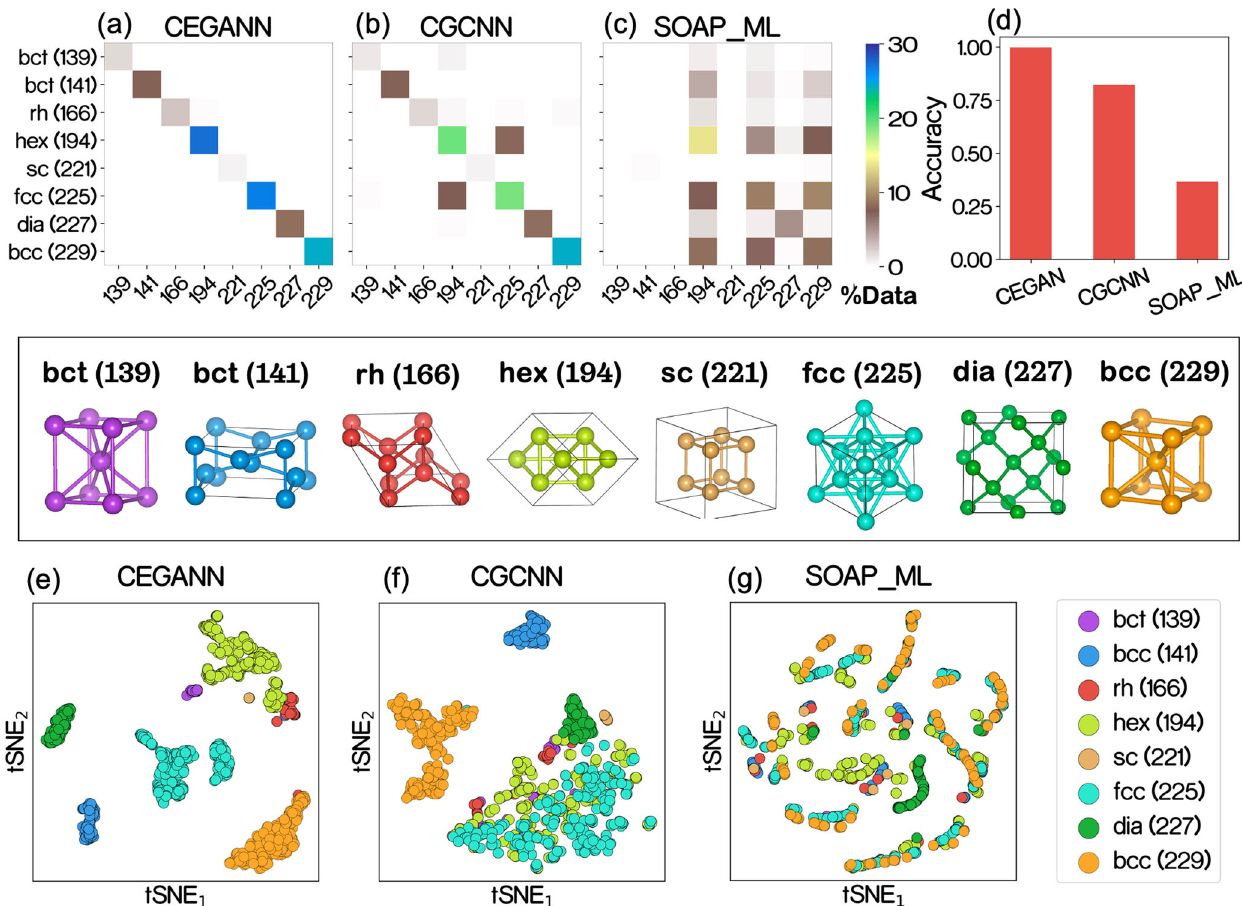
Fig. 3 Global classi fi cation of crystals structures based on space groups. a – c Shows the confusion matrix for CEGANN, CGCNN, SOAP_ML, and work fl ow respectively. d Shows accuracy of prediction on the test set for the three different architectures used. e – g Show the t-SNE plot of the embeddings in feature space as learned by the CEGANN, CGCNN, and SOAP_ML,